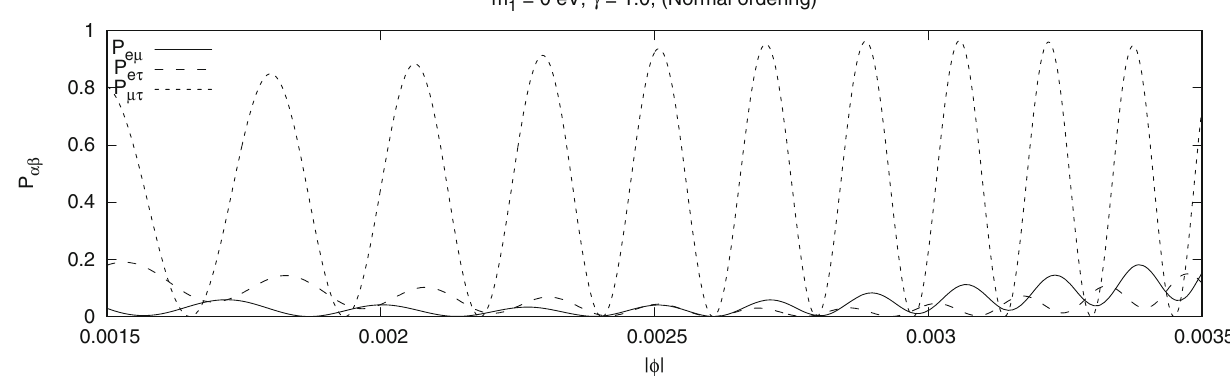
Fig. 6 Probability of ν α → ν β conversion, for different α and β , as function of the azimuthal angle φ in the three flavor case for γ = 1 (spherical symmetry). The solid, dashed and the dotted lines represent the ν e → ν μ , ν e → ν τ and ν μ → ν τ conversion probabilities, respec-